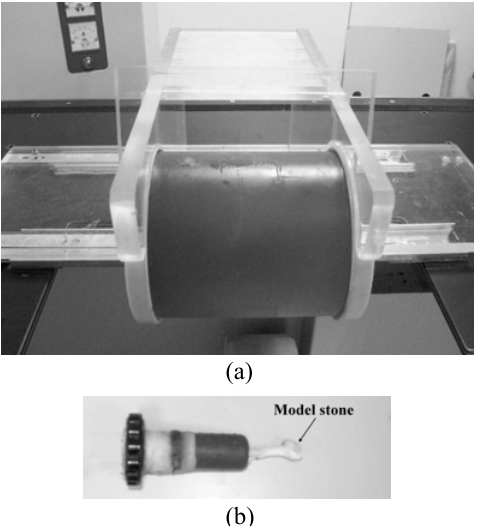
Figure 6. ( a ) The phantom with kidney-shaped cavity mounted on the ESWL, and ( b ) the phantom cap attached with a model stone at the tip.